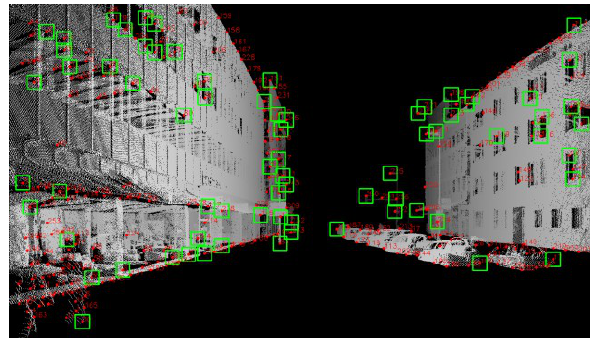
Figure 6. Feature points extracted by our approach on the range image (Candidates detected by Shi-Tomasi corner detector as red points, the selected feature points in green windows)